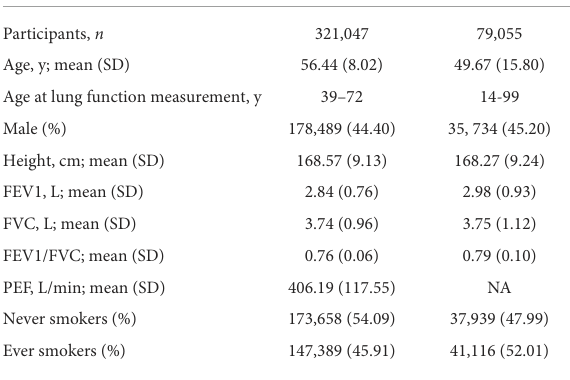
TABLE 1 Baseline characteristics of participants included in the analysis. Characteristics